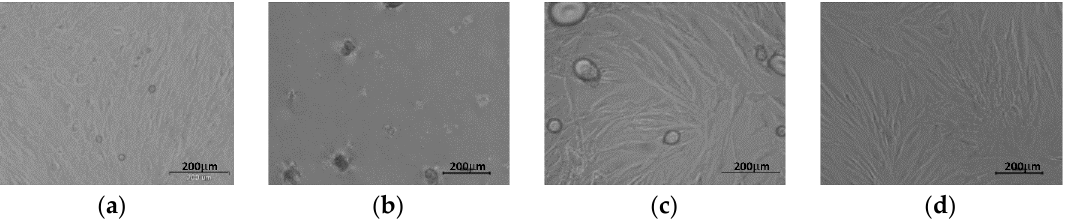
Figure 7. Morphology of fibroblasts cultured on P(iPrOx-nPrOx) after 72 h of cell culture: ( a ) Film 1; ( b ) Film 2; ( c ) Film 3; and ( d ) TCPS.